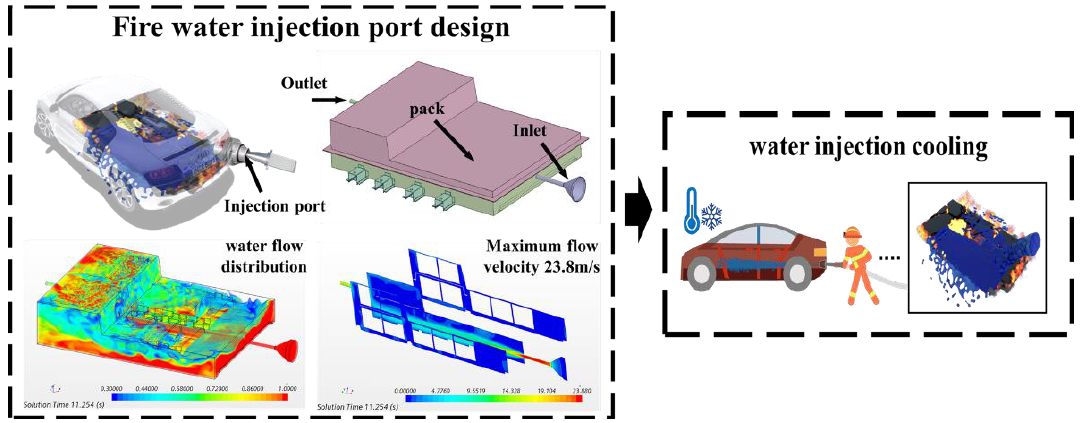
Figure 9. Structure design of a firewater injection port for EVs.